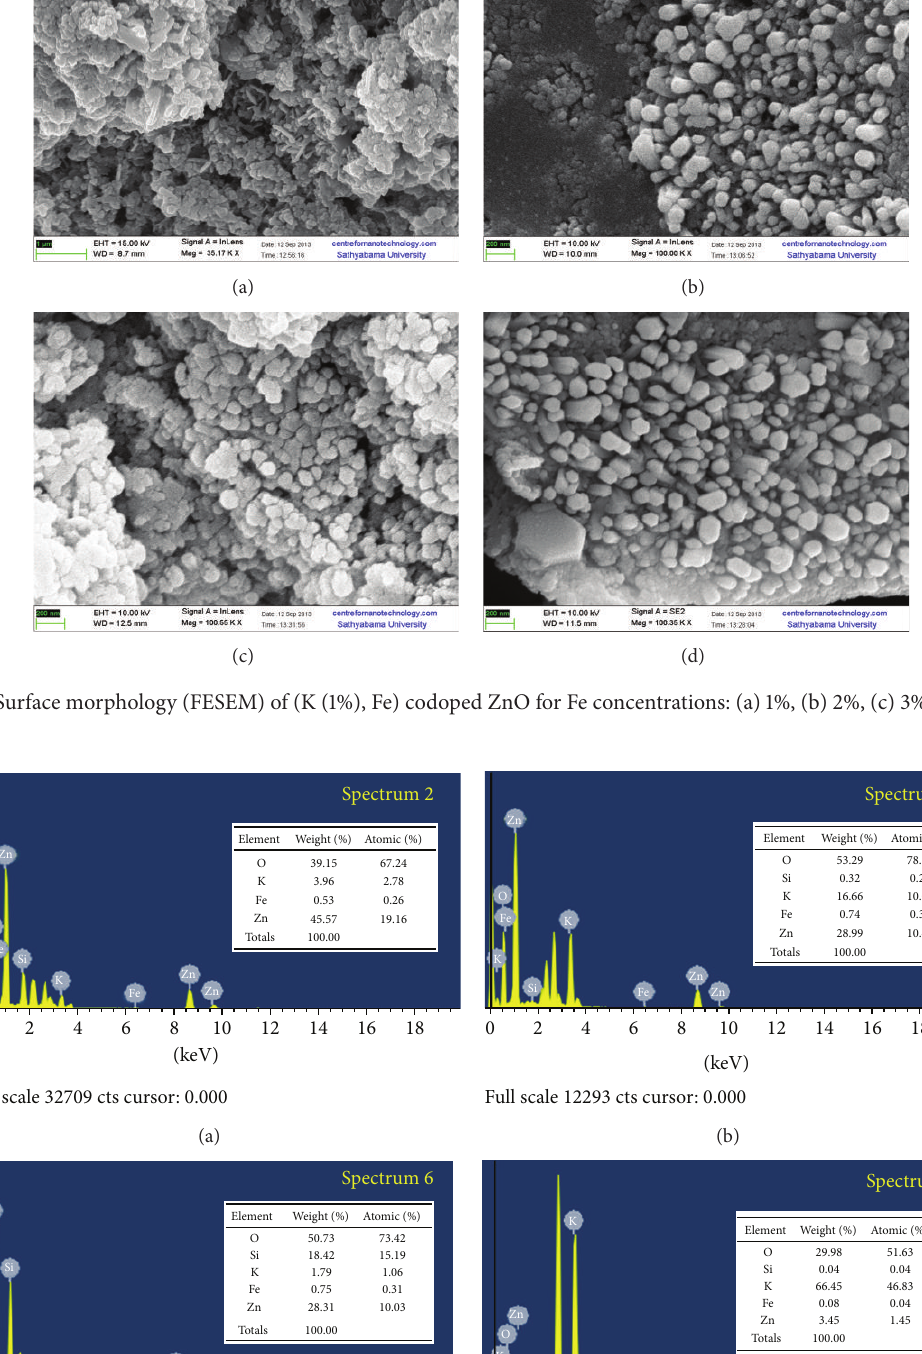
Full scale 18948 cts cursor: 0.000